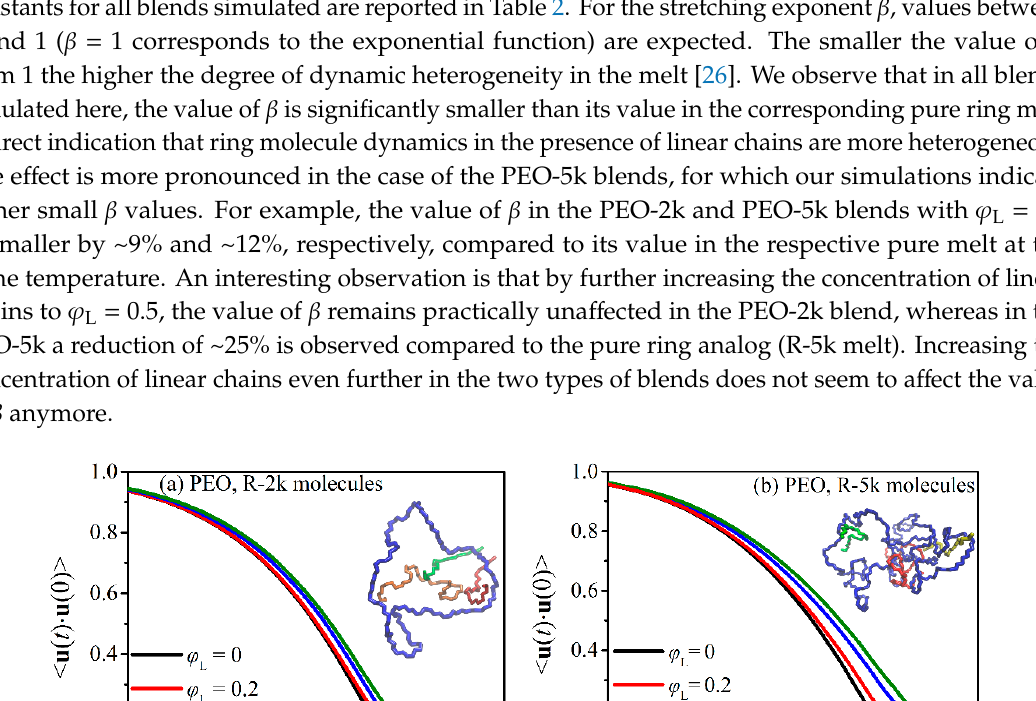
Figure 2. Decay of the time autocorrelation function in: ( a ) the PEO-2k blends, and ( b ) the PEO-5k blends. The curves for the two pure ring melts are from Ref. [25].